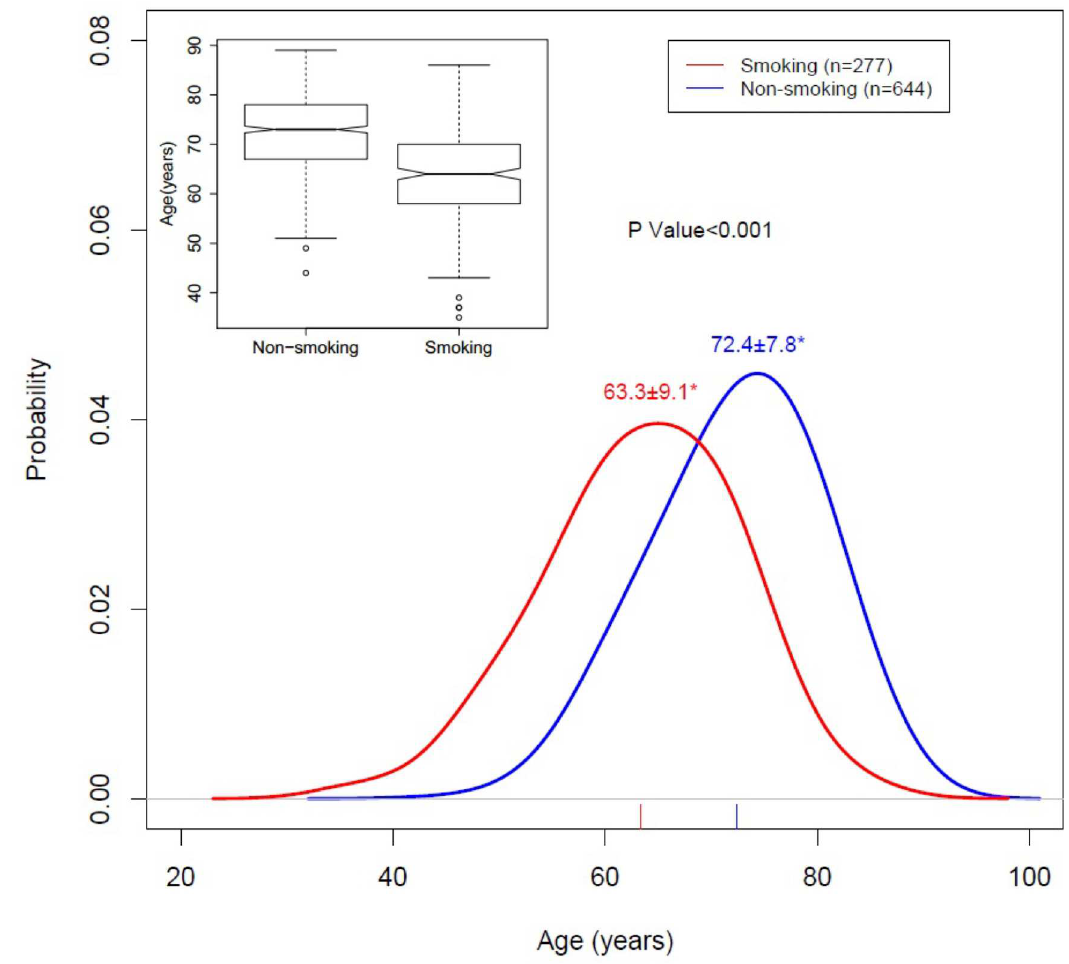
Fig 2. Age in yearsfor smokersand non-smokers at study enrollment. The Red curve represents the distribution of age for smokers (N = 277) and the blue curve represents age at study enrollment for non-smokers (N = 644). Numbers at the peak of the distribution curves are the mean years of age at study enrollment ± SD for the patient populations as definedabove. The insert boxplot shows age with interquartile ranges and 95% confidenceintervals differentiatedby smoking status. The asterisk ( * ) indicatesthat the means are significantly different (p < 0.001)as determinedby two-sample